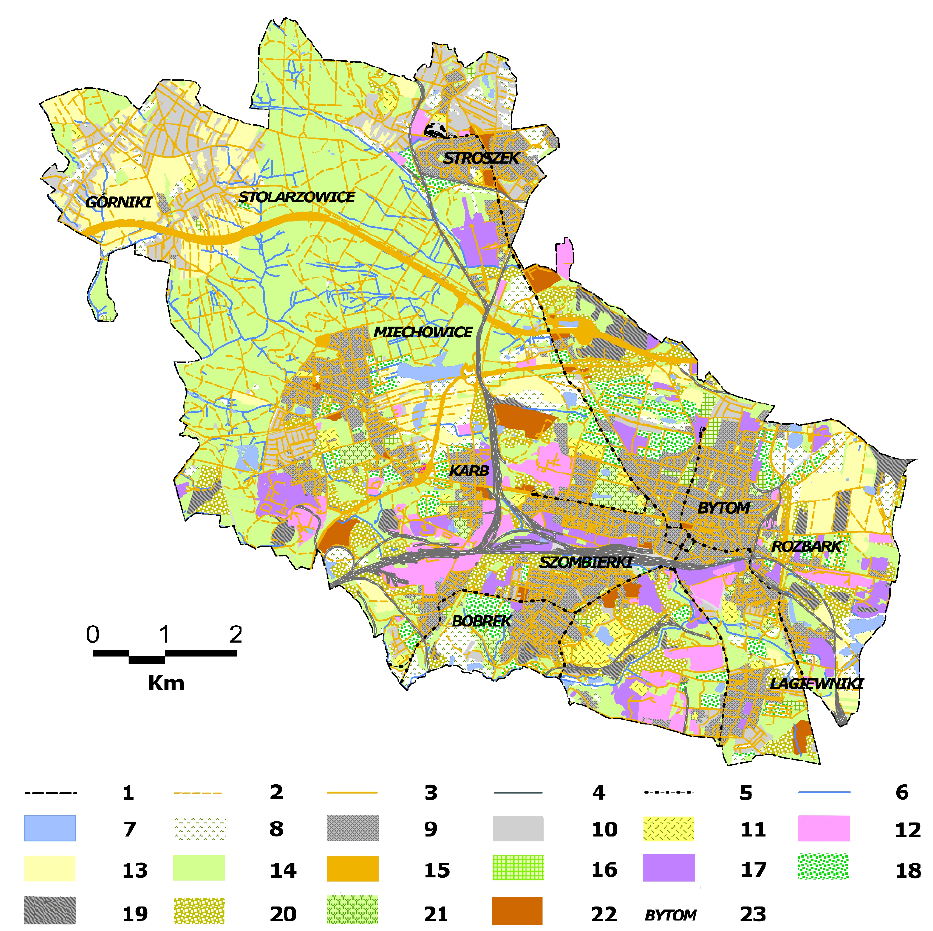
Figure 6. The land use of the area of Bytom in 2019 (Sourced by authors on the basis of https://mapy.orsip.pl/imap/?gpmap=gp1-2) (accessed on 1 November 2020). Explanations: 1—current city border; 2—dirt roads; 3—paved roads; 4—railway lines; 5—tram lines; 6—water courses; 7—water reservoirs; 8—meadows; 9—dense buildings; 10—dispersed buildings, railway areas; 11—sports facilities; 12—industrial areas; 13—arable fields, fallow lands; 14—forests and trees; 15—road areas; 16—cemeteries; 17—postindustrial areas; 18—allotment gardens; 19—dumps; 20—wastelands, landfills; 21—parks, squares, and lawns; 22—malls; 23—topographic names.